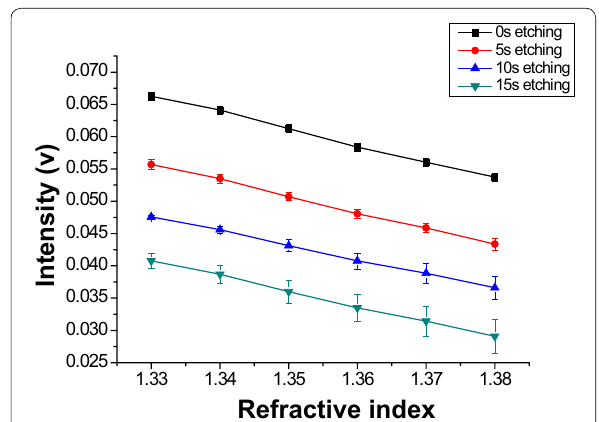
Fig. 6 Change of background noise due to refractive indices